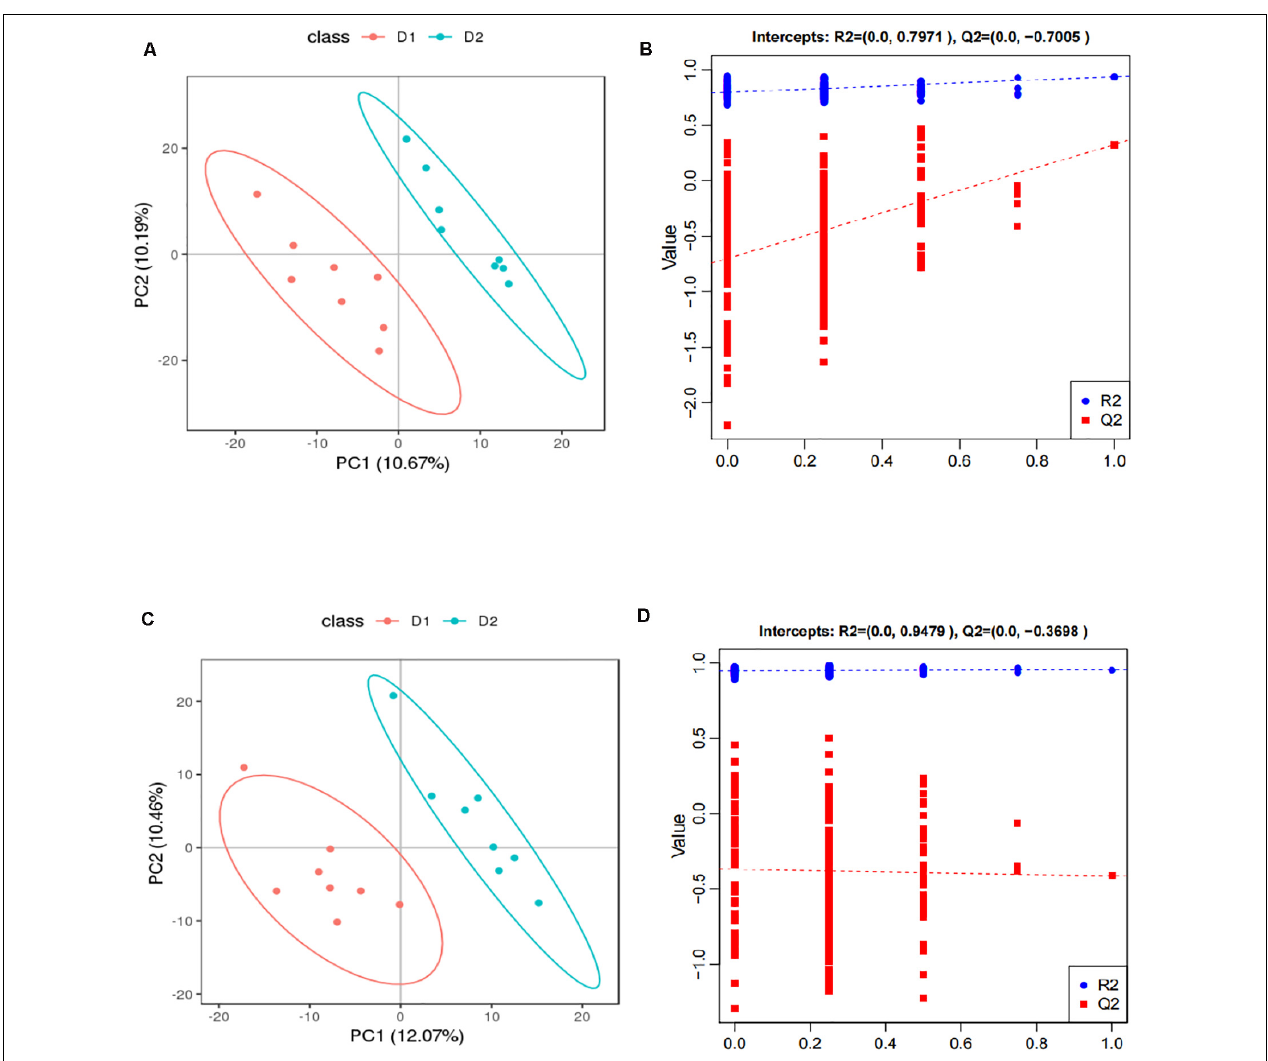
FIGURE 1 | The score plots and validation plots of PLS-DA from liver metabolite profiles of American eel in the control group and HIS group under positive ion mode (A,B) and negative ion mode (C,D) ( n = 8). D 1 = control group, D 2 = HIS group.